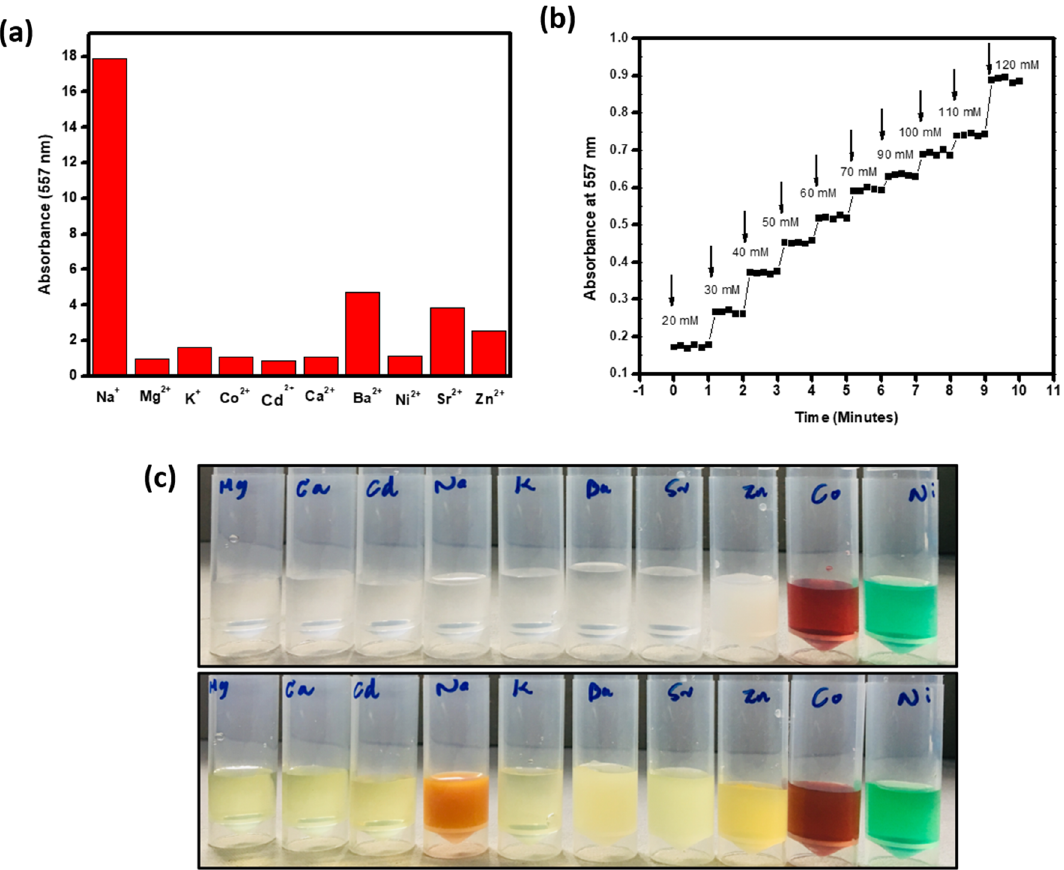
Figure 5. ( a ) Absorbance response of CuC solution in the presence of different metal ions in aqueous solution. ( b ) The absorbance vs time plot of Na + in different concentrations (20–120 mM). ( c ) The photograph of different metal ions before and after adding CuC colorimetric sensing probe